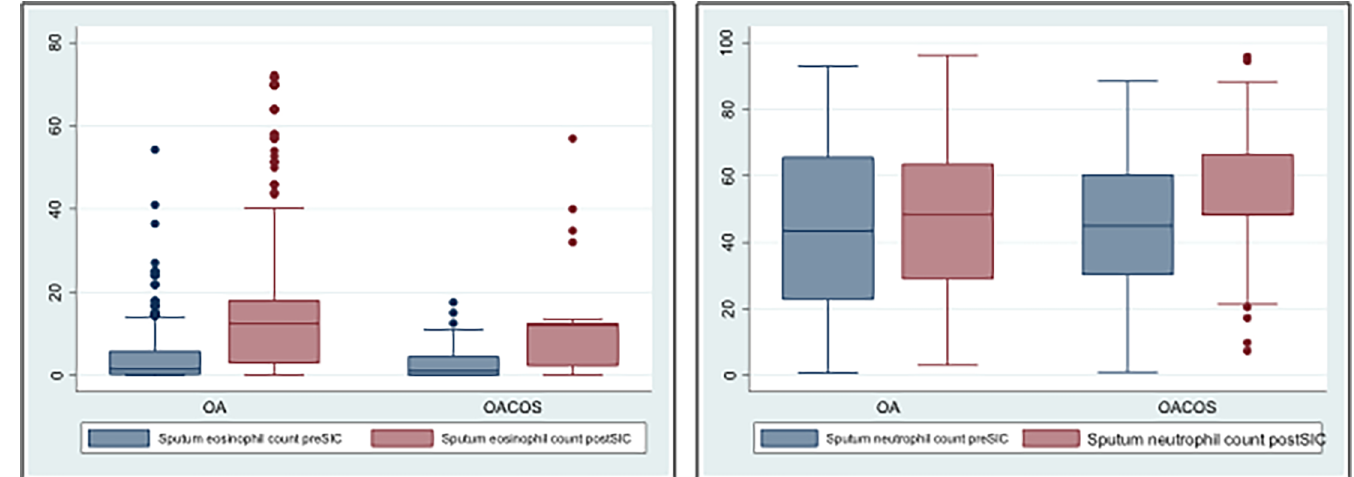
Fig 2. Sputum eosinophil and neutrophil counts before and after SIC in OA and OACO patients. OA: occupational asthma; OACO: occupational asthma COPD overlap; SIC: specific inhalation challenge.